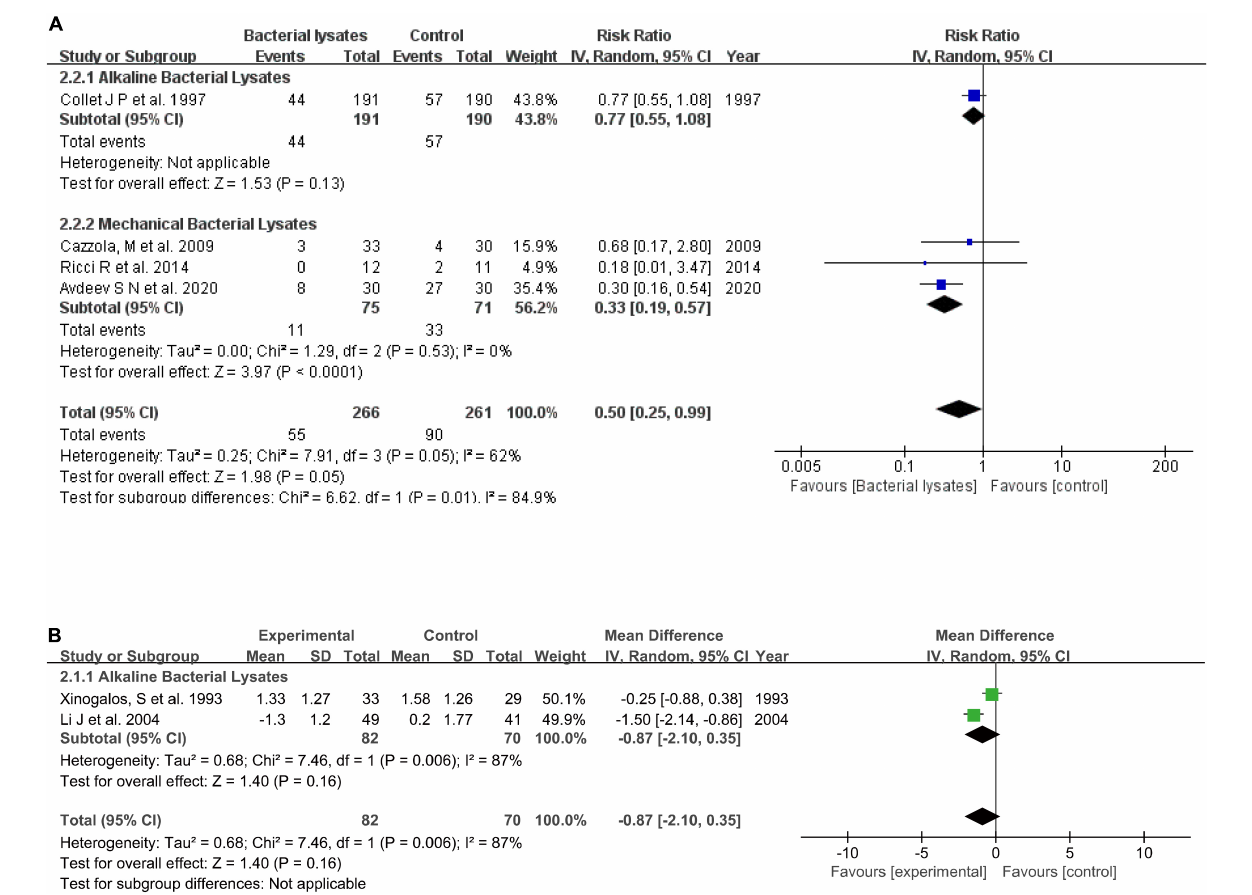
FIGURE 4 | Forest plots of the efficacy of bacterial lysates on respiratory infections and hospitalization. (A) Rate of hospitalization. (B) Mean number of respiratory infections.